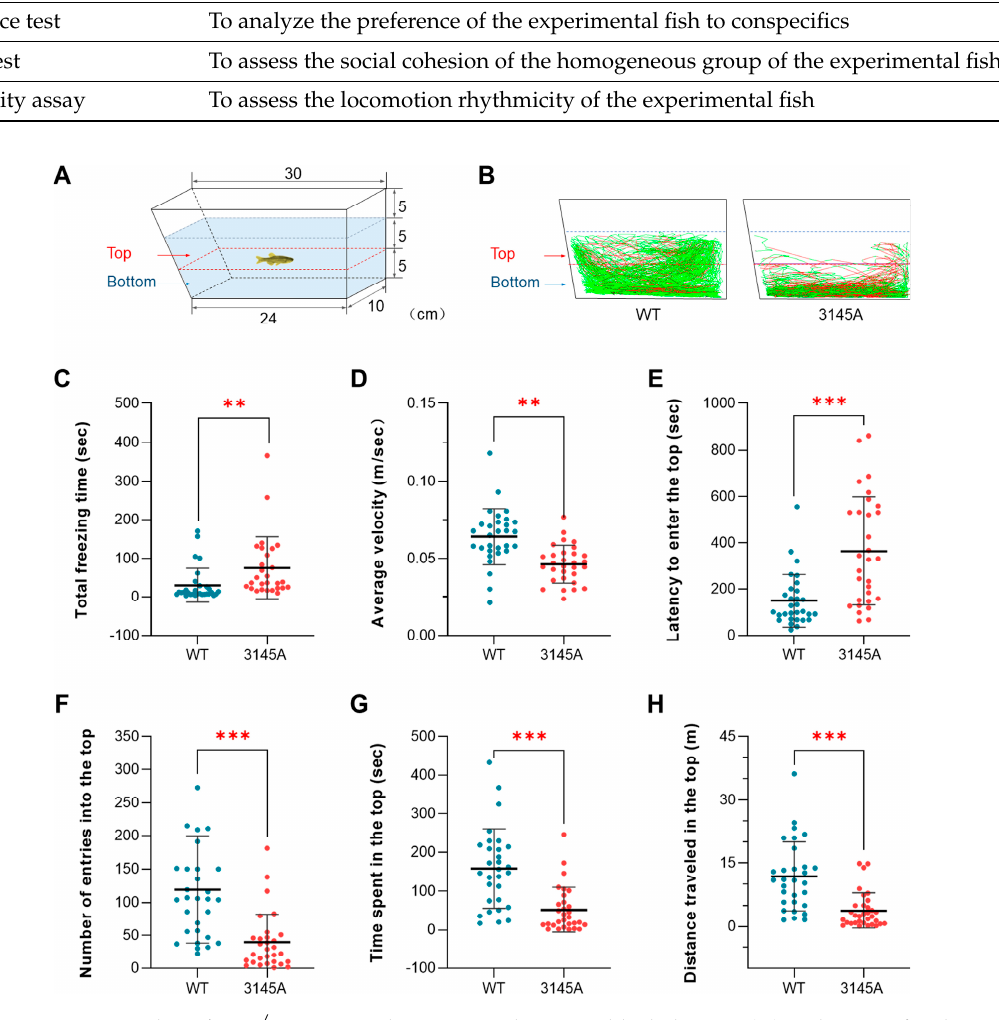
Figure 3. The prkcaa − / − mutants demonstrated anxiety-like behavior. ( A ) A diagram for the novel tank. The tank was divided into 2 parts with a dashed red line: the top and the bottom. The numbers indicate tank size and water depth (cm). ( B ) Representative tracked trajectories of the WT and 3145A fish. The red and green line segments represent large (>15 cm/s) and moderate (1–15 cm/s) movements, respectively. ( C ) Total freezing time. ( D ) Average velocity. ( E ) Latency to enter the top. ( F ) Number of entries into the top. ( G ) Time spent in the top. ( H ) Distance traveled in the top. The error bars represent standard error ( n = 30). **, p < 0.01; ***, p <